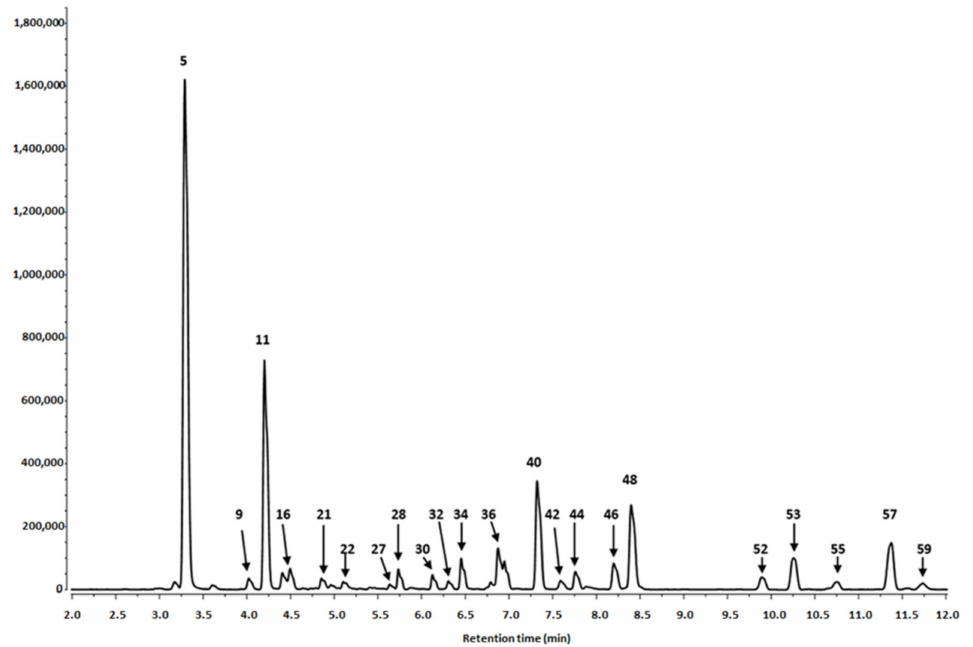
Figure 1. Segment from 2.00 to 12.00 min of LC-DAD chromatogram at 340 nm of S. alba leaves. Peak number identities are displayed in Table 1.